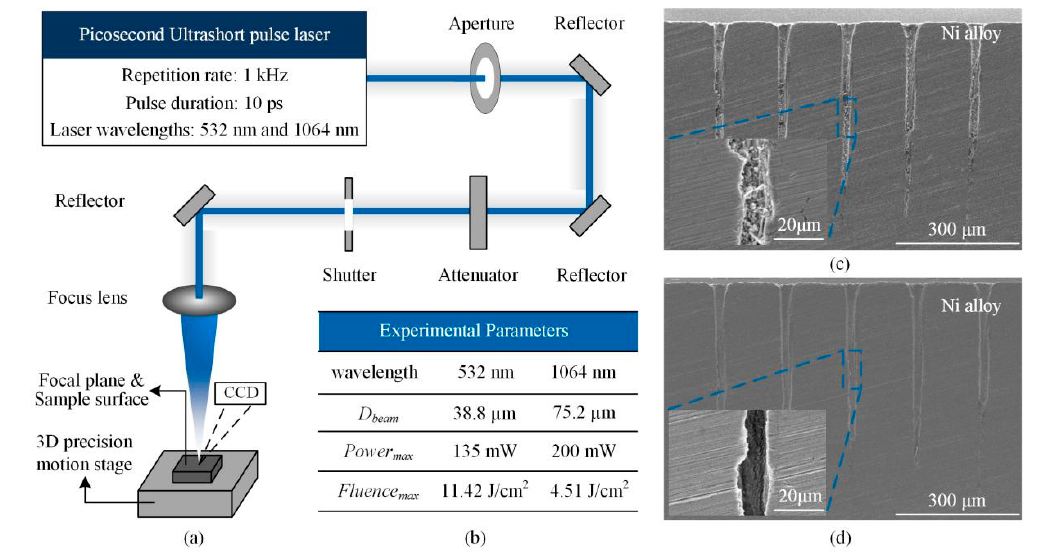
Figure 1. Machining system, experimental parameters and SEM images of hole profile ( a ): Schematic of the picosecond ultrashort laser micro-machining system; ( b ): Experimental Parameters; ( c ): SEM images of the hole profile before cleaned; ( d ): SEM images of the hole profile after cleaned.